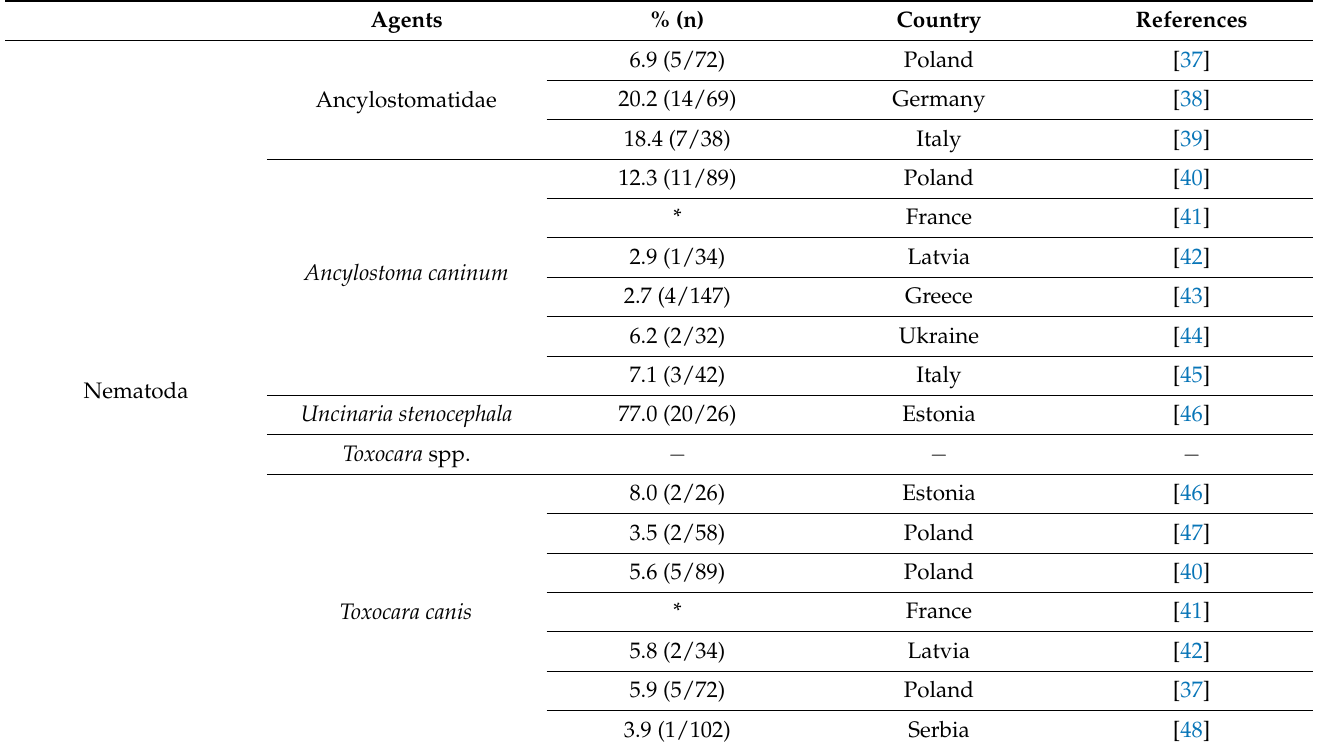
Table 6. Prevalence (%) of parasitic agents with zoonotic potential reported in wolves in Europe [37–51]. Agents % (n)